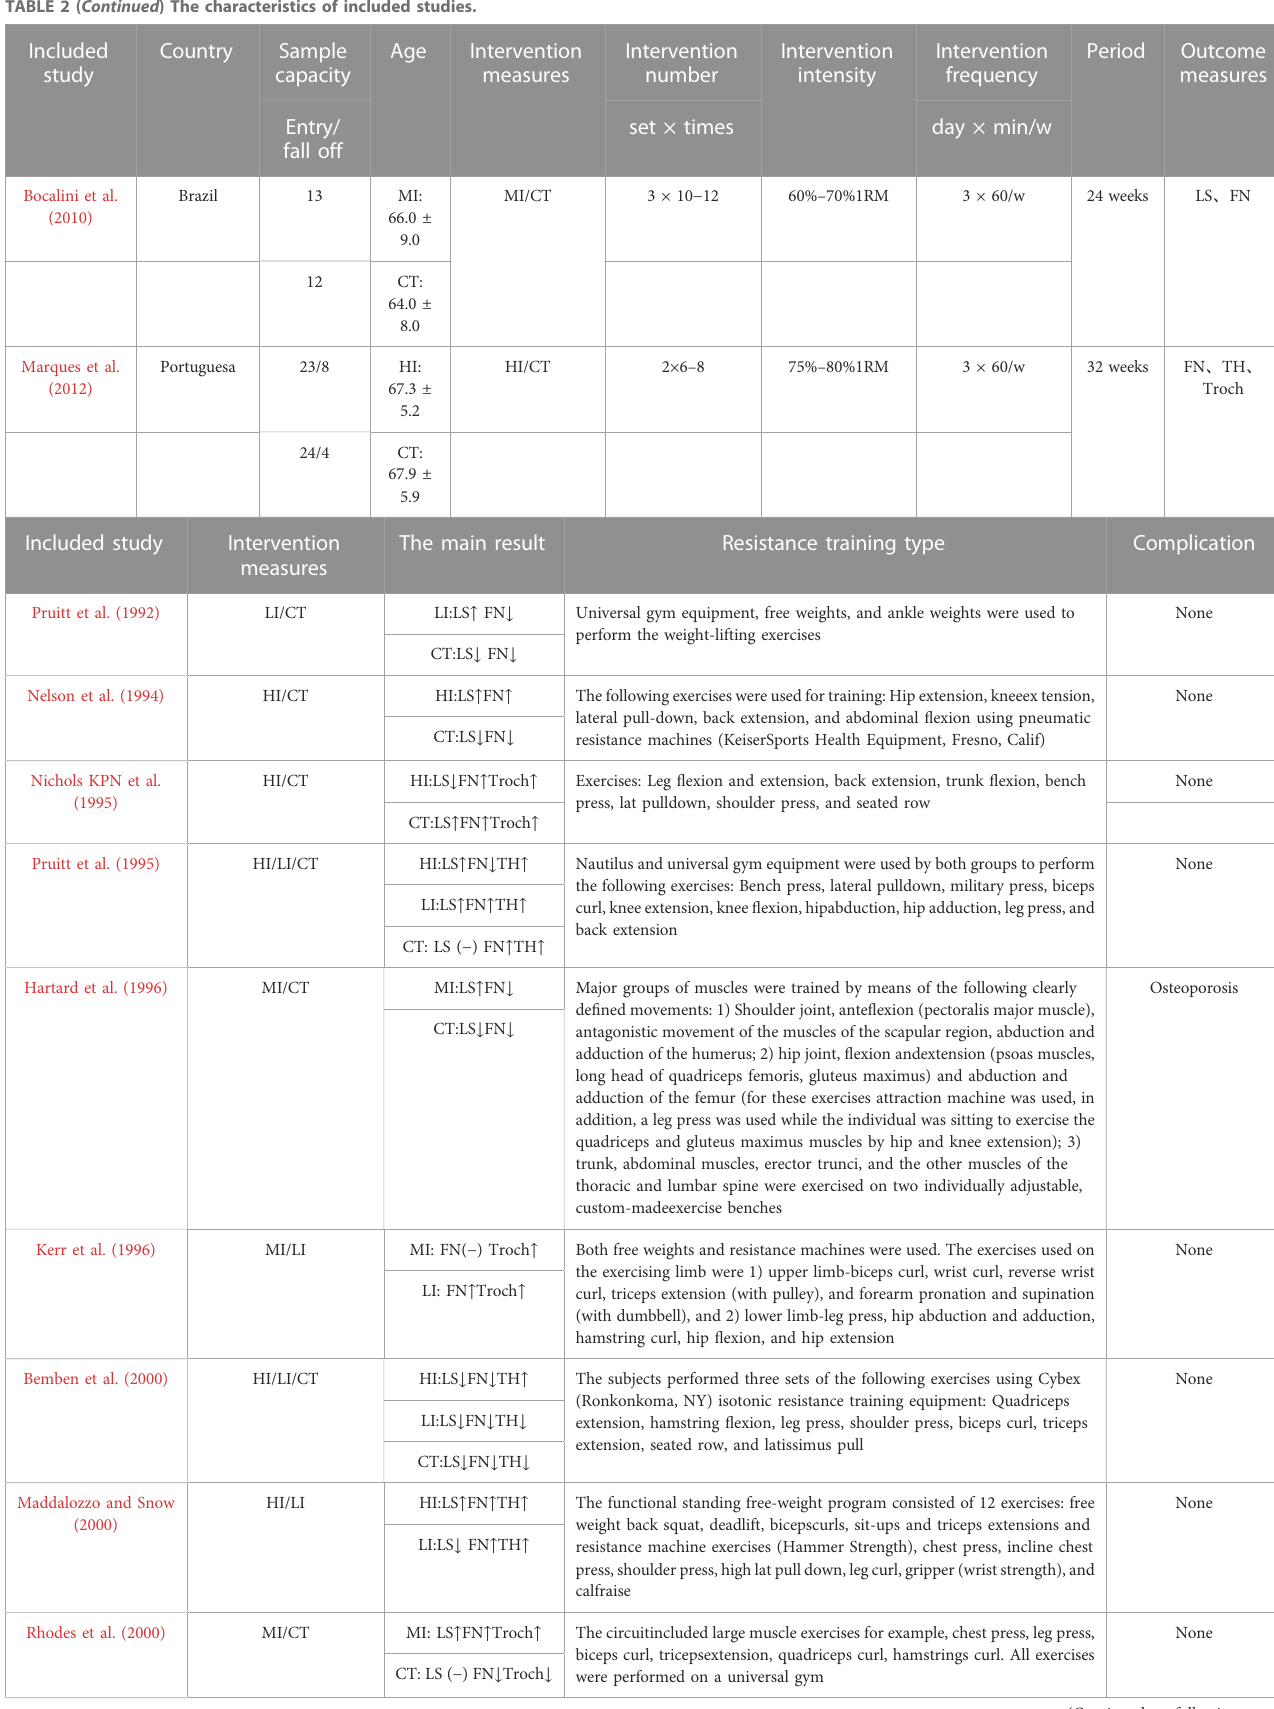
Both free weights and resistance machines were used. The exercises used on the exercising limb were 1) upper limb-biceps curl, wrist curl, reverse wrist curl, triceps extension (with pulley), and forearm pronation and supination (with dumbbell), and 2) lower limb-leg press, hip abduction and adduction, hamstring curl, hip fl exion, and hip extension The subjects performed three sets of the following exercises using Cybex (Ronkonkoma, NY) isotonic resistance training equipment: Quadriceps extension, hamstring fl exion, leg press, shoulder press, biceps curl, triceps extension, seated row, and latissimus pull The functional standing free-weight program consisted of 12 exercises: free weight back squat, deadlift, bicepscurls, sit-ups and triceps extensions and resistance machine exercises (Hammer Strength), chest press, incline chest press,shoulderpress,highlatpulldown,legcurl,gripper(wriststrength),and calfraise The circuitincluded large muscle exercises for example, chest press, leg press, biceps curl, tricepsextension, quadriceps curl, hamstrings curl. All exercises CT: LS ( − ) FN ↓ Troch were performed on a universal gym